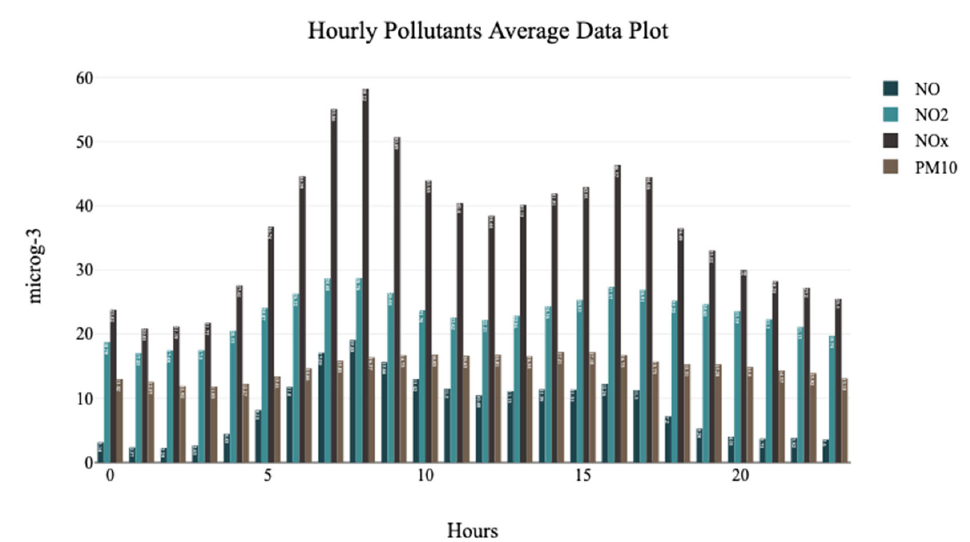
Figure 5. A. Standard regulatory air quality measure levels alongside NOx filter derived MP levels. Sampling timepoints were as follows: 1, 22/10/19–12/11/19 (21 days); 2, 02/12/19–27/01/20 (56 days); 3, 27/01/20–16/03/20 (49 days); 4, 01/04/20–29/04/20 (28 days); 5, 29/04/20–03/06/20 (35 days); 6, 01/07/20–29/07/20 (28 days). B. Monthly standard air quality measured data from same period and sampling location. C. Hourly snapshot of the mean standard air quality measured data for the same period and sampling location.